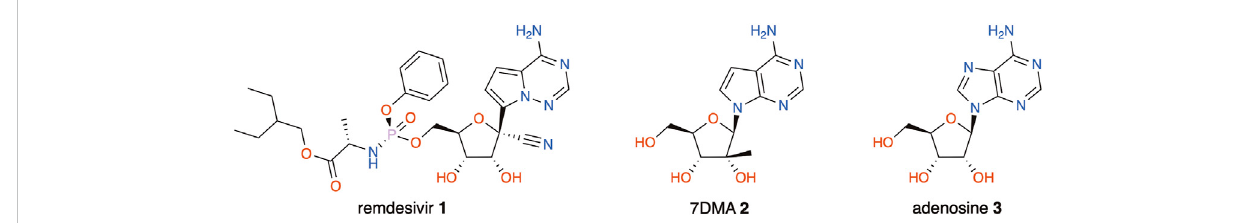
FIGURE 1 Antiviral agents remdesivir ( 1 ), 7DMA ( 2 ), and the nucleobase adenosine ( 3 ).